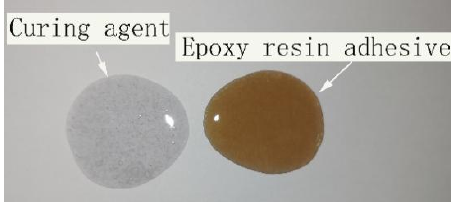
Figure 1. Dip adhesive.